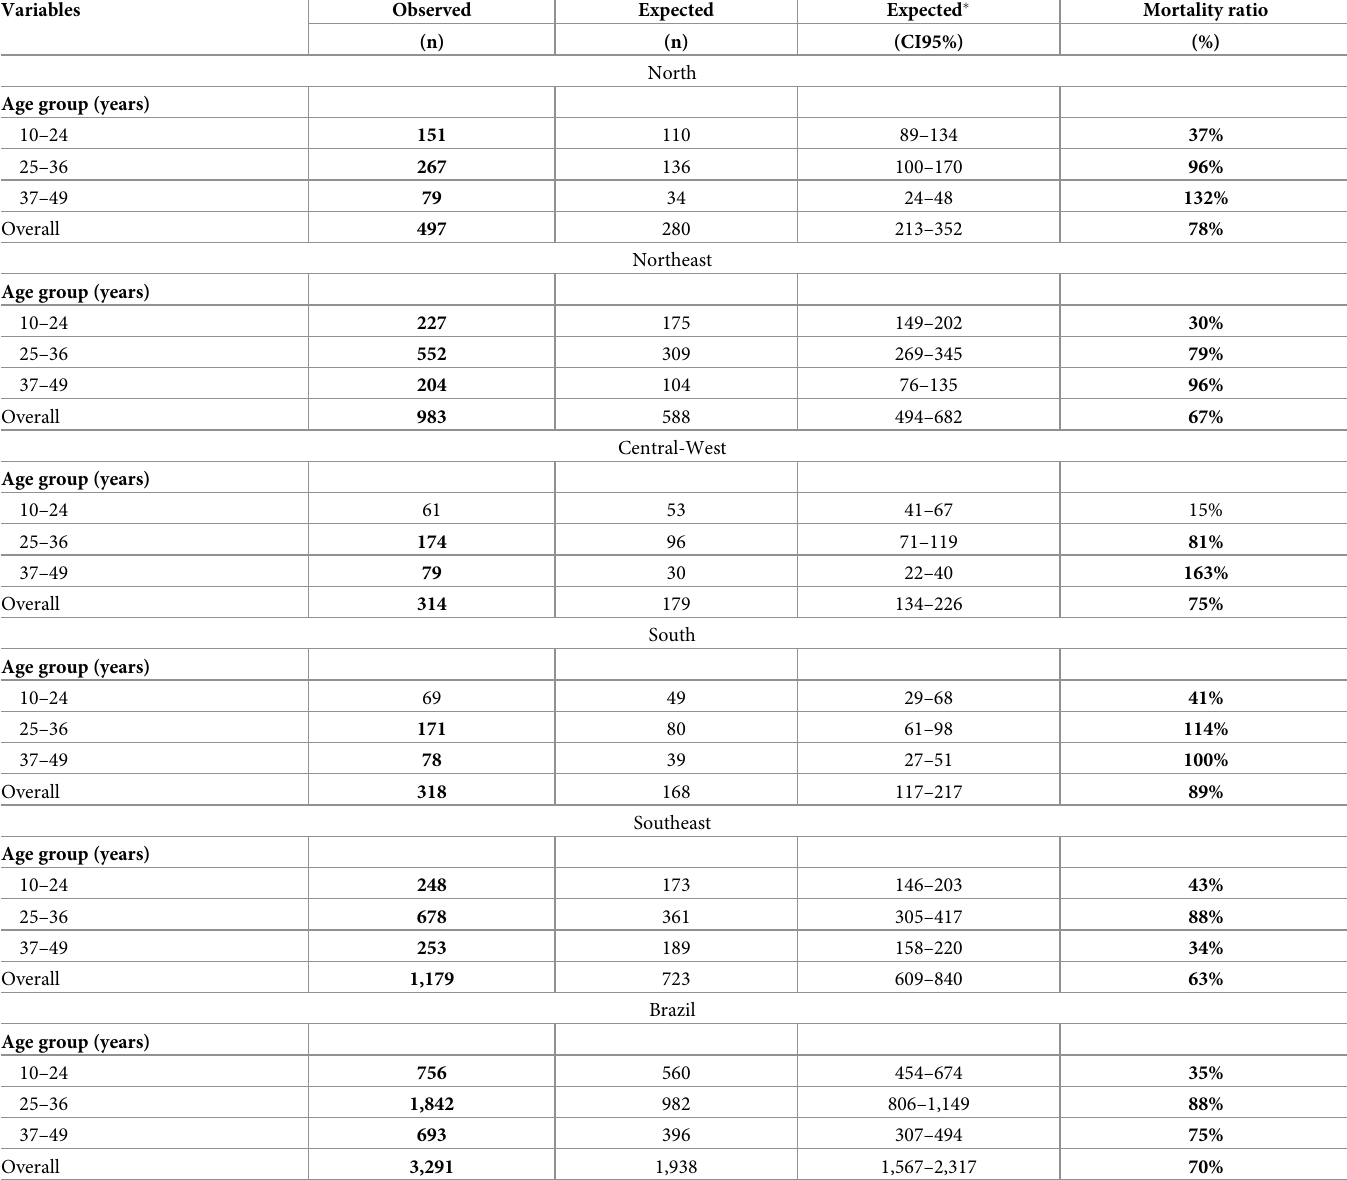
Table 1. Percentage of excess maternal deaths by age group and region, Brazil, 2020–2021.